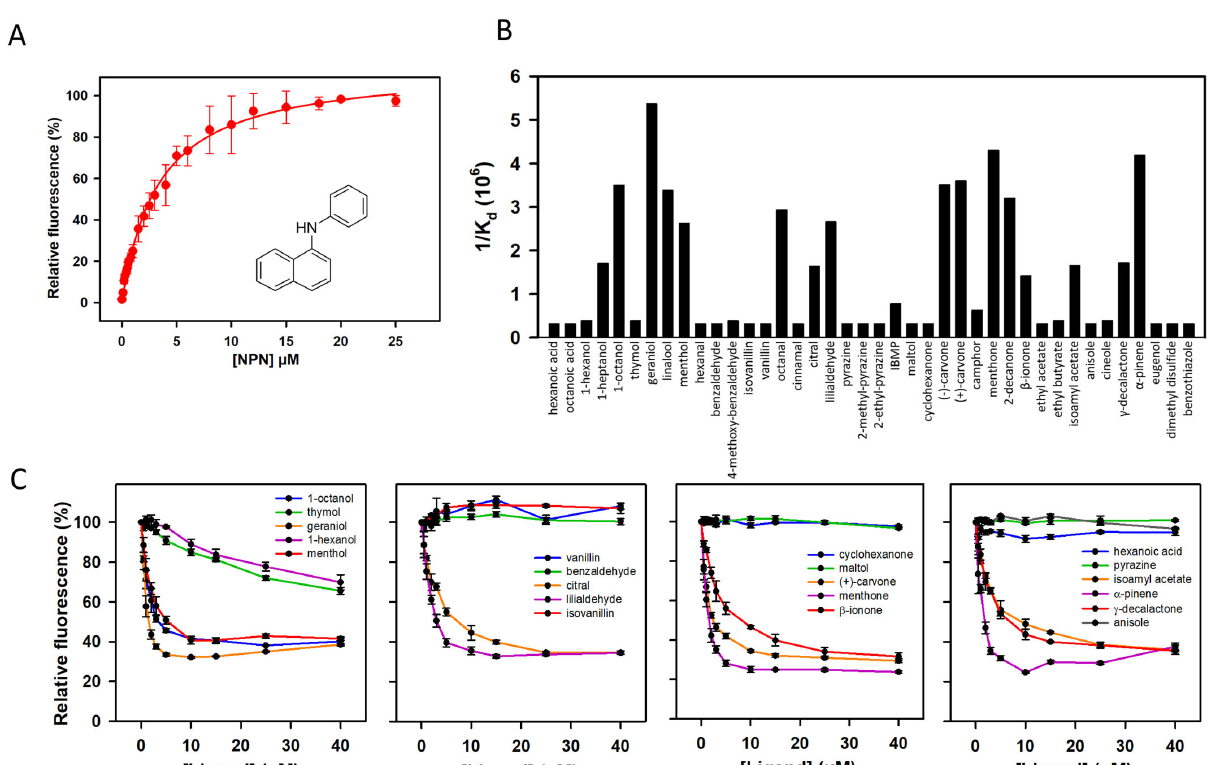
Figure 3. Binding properties of mOBP5 measured using a competitive fluorescent assay. ( A ) Titration curve of mOBP5 with NPN; circles show experimental data, while the solid lines are the computed binding curves; excitation and emission wavelengths were 337 and 420 nm, respectively; the mOBP5 concentration was 2 μ M. The NPN structure is inserted. ( B ) Affinity of mOBP5 toward the 40 tested odorants clustered by chemical families. ( C ) Examples of competitive binding curves toward NPN with several odorants. The fluorescence of the NPN ‐ mOBP5 complex was designated as 100% in the absence of a competitor.